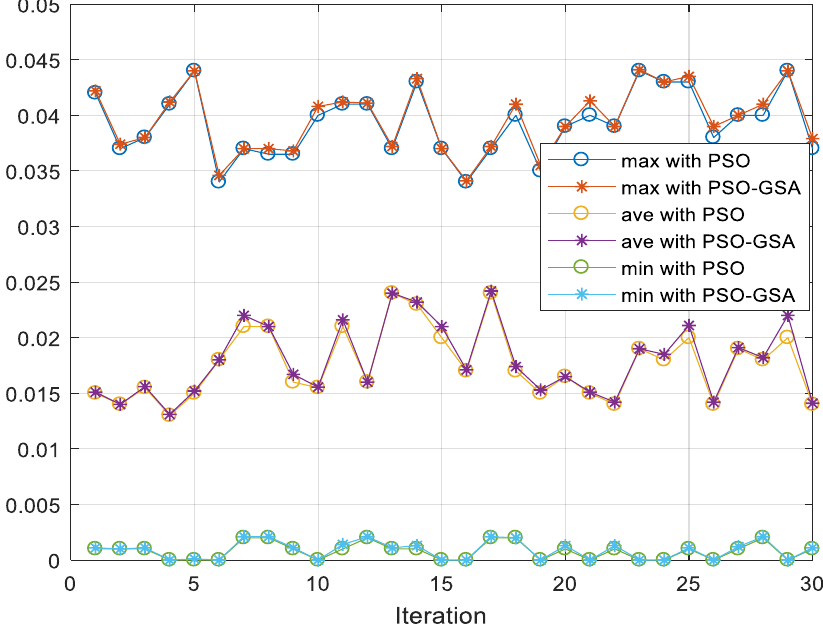
Figure 17. Best value obtained from 30 different implementations for the standard test function.